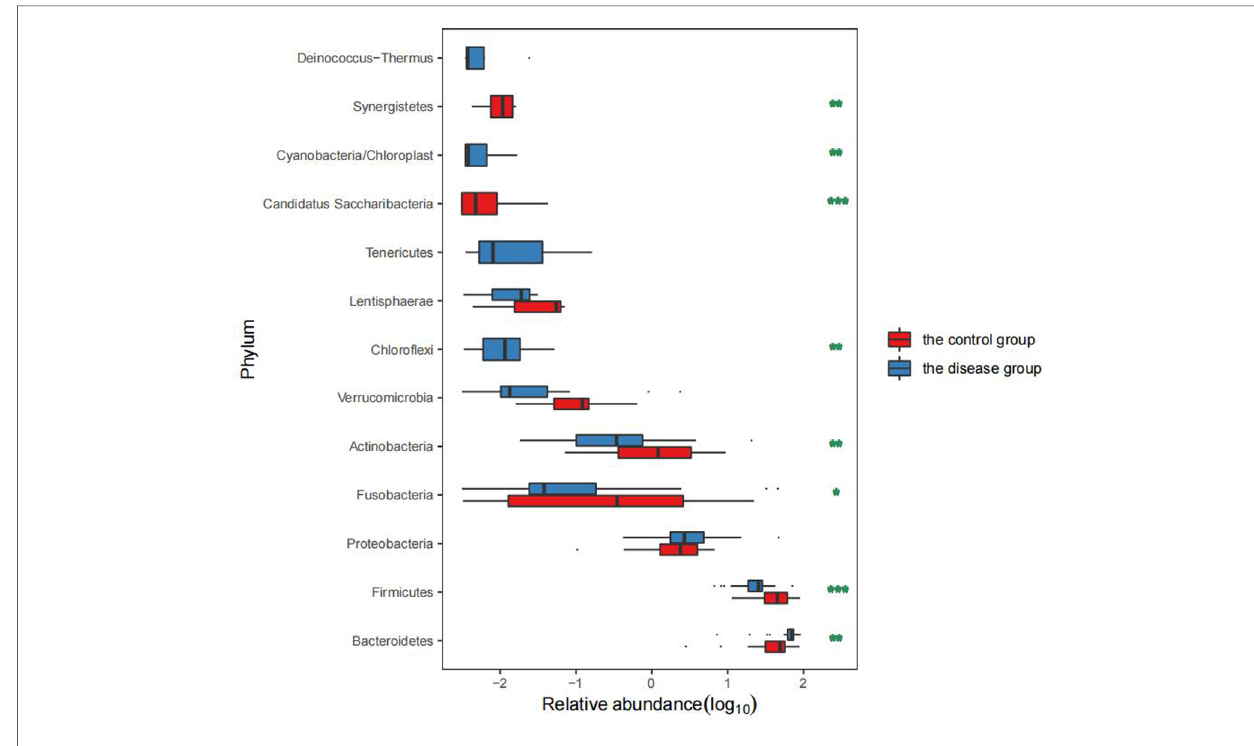
FIGURE 3 Comparison of the GM levels in the two groups.